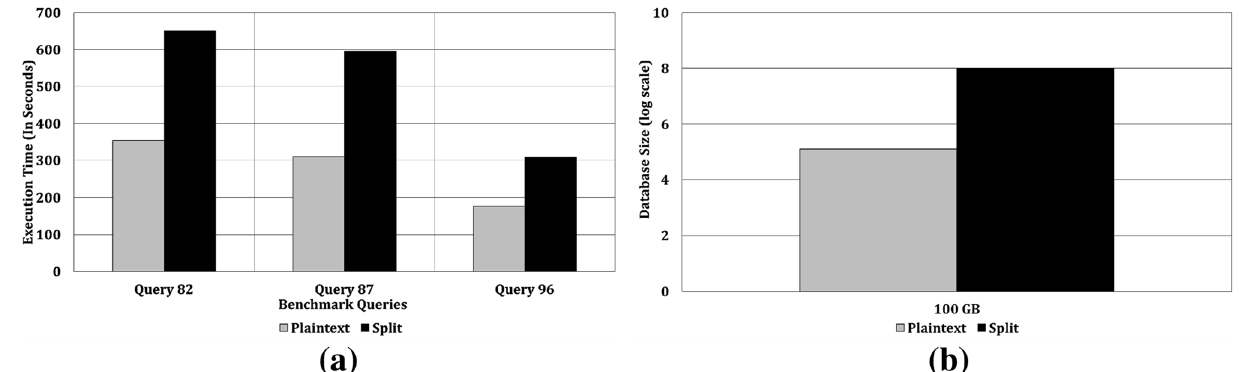
Fig. 9 a Query execution time and b database size for 100 GB TPC-DS benchmark